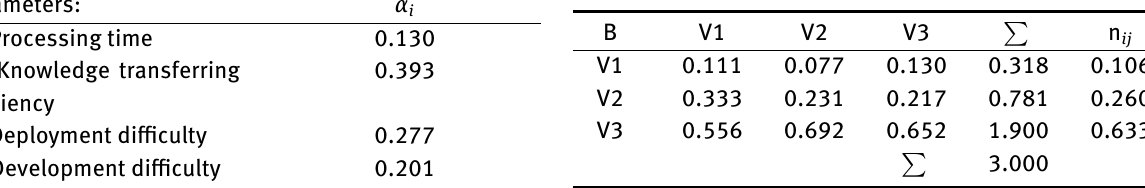
Table 4: Final weights of parameters.